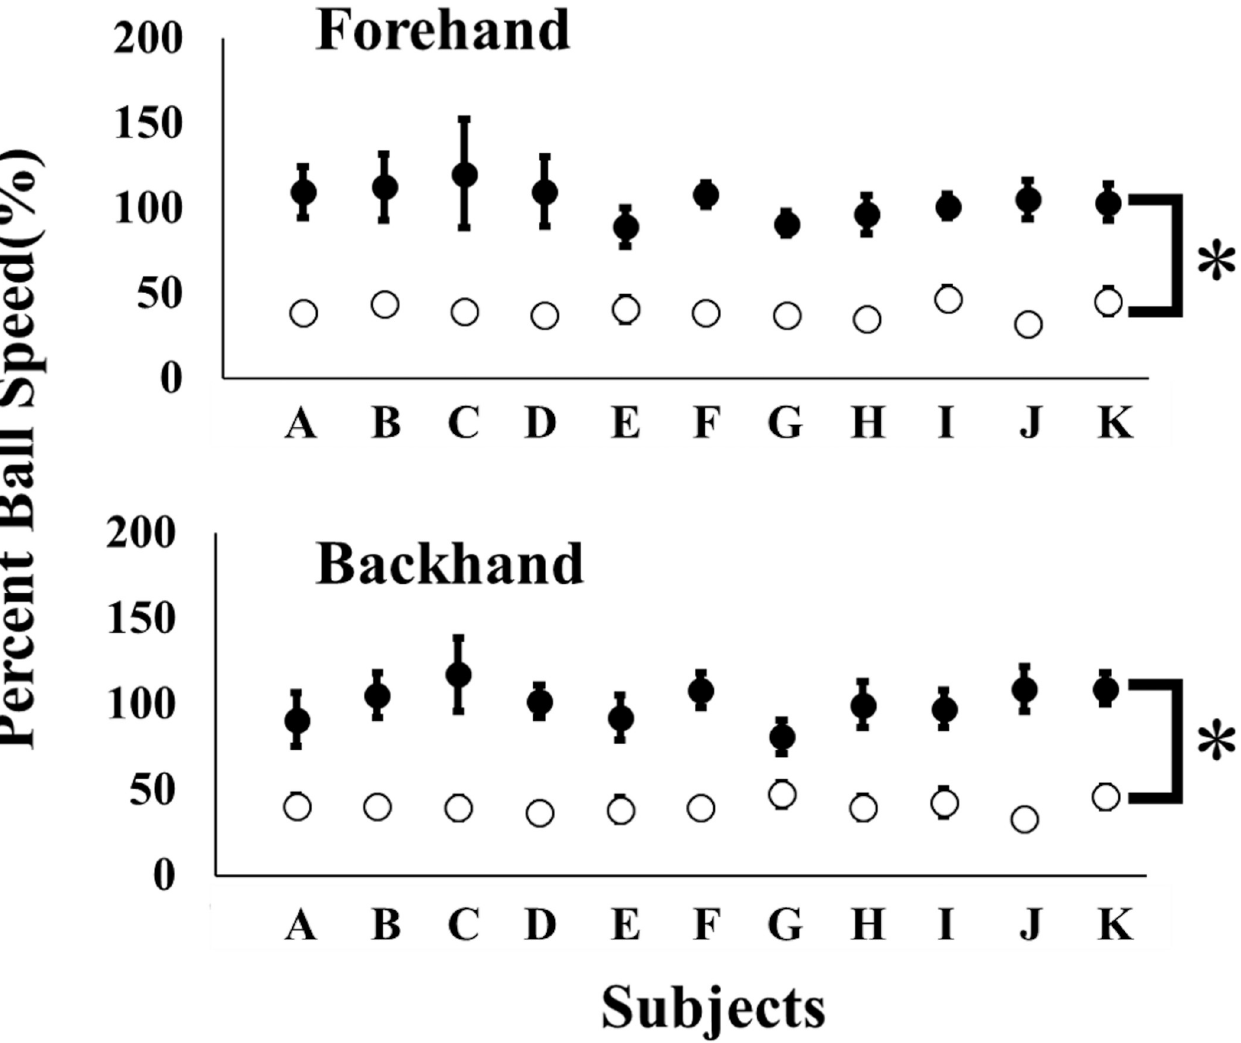
Fig 2. Percent ball speed. The percent ball speed of the drop volley is significantly lower than the standard volley in all subjects (A~K, � p < 0.05). Open and closed circles donated the drop volley and the standard volley, respectively. The x-component of racket head velocity in the period 30 ms before impact was greater for the backhand drop volley (3 ± 1.8m/s) than for the forehand drop volley (1.1 ± 1.1 m/s) (p < 0.05), but there was no difference between the forehand and backhand standard volley.